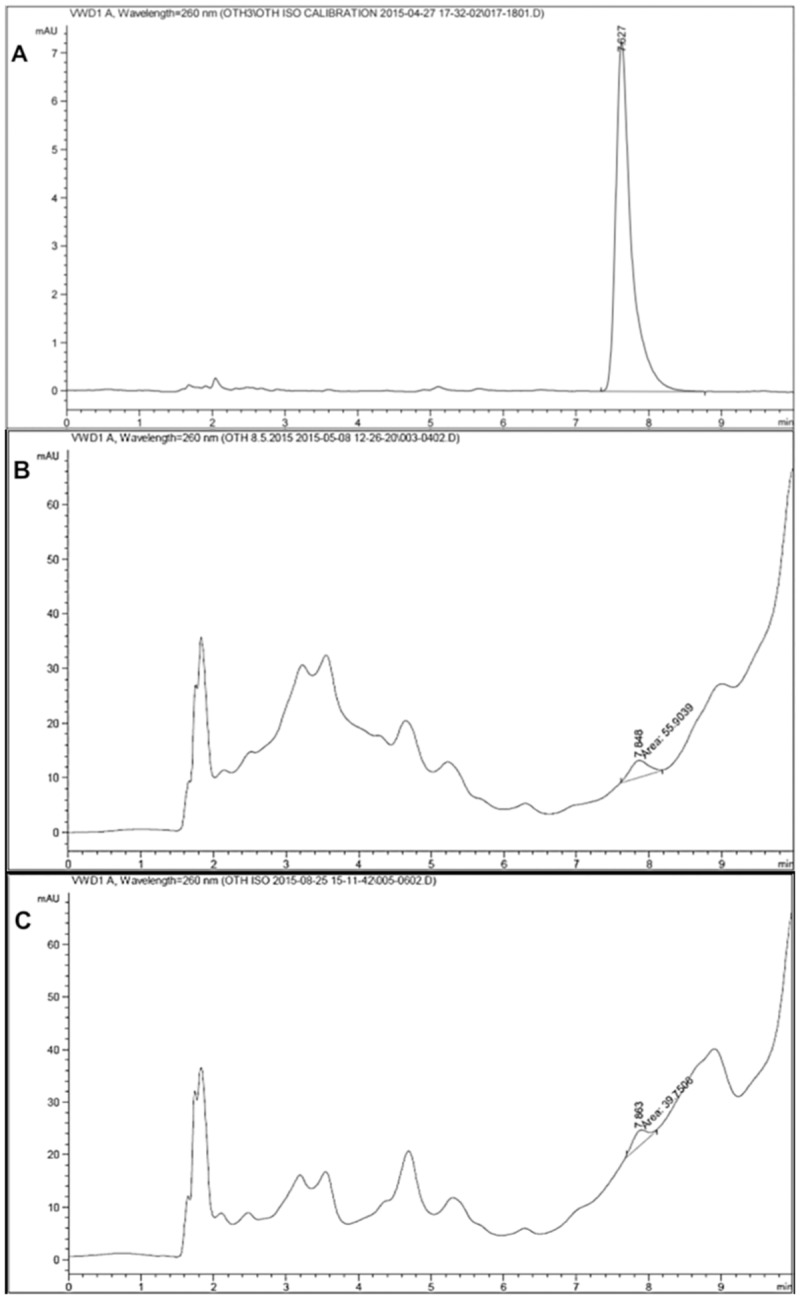
HPLC chromatograms depicting the elution profile of standard flavonoid compounds and extracts of Malaysian propolis by isocratic elution.A) Chromatograms depicting the identification and quantification of standard flavonoid marker compound pinocembrin. B and C) Chromatograms depicting the standardisation of Eth extract (B) or EA extract (C) of Malaysian propolis using pinocembrin. A comparison of the flavonoid content of Eth and EA extracts of Malaysian propolis revealed that kaempferol concentration is similar between the two extracts (Table 3), while the amount of pinocembrin present is higher in Eth extract compared to EA extract.